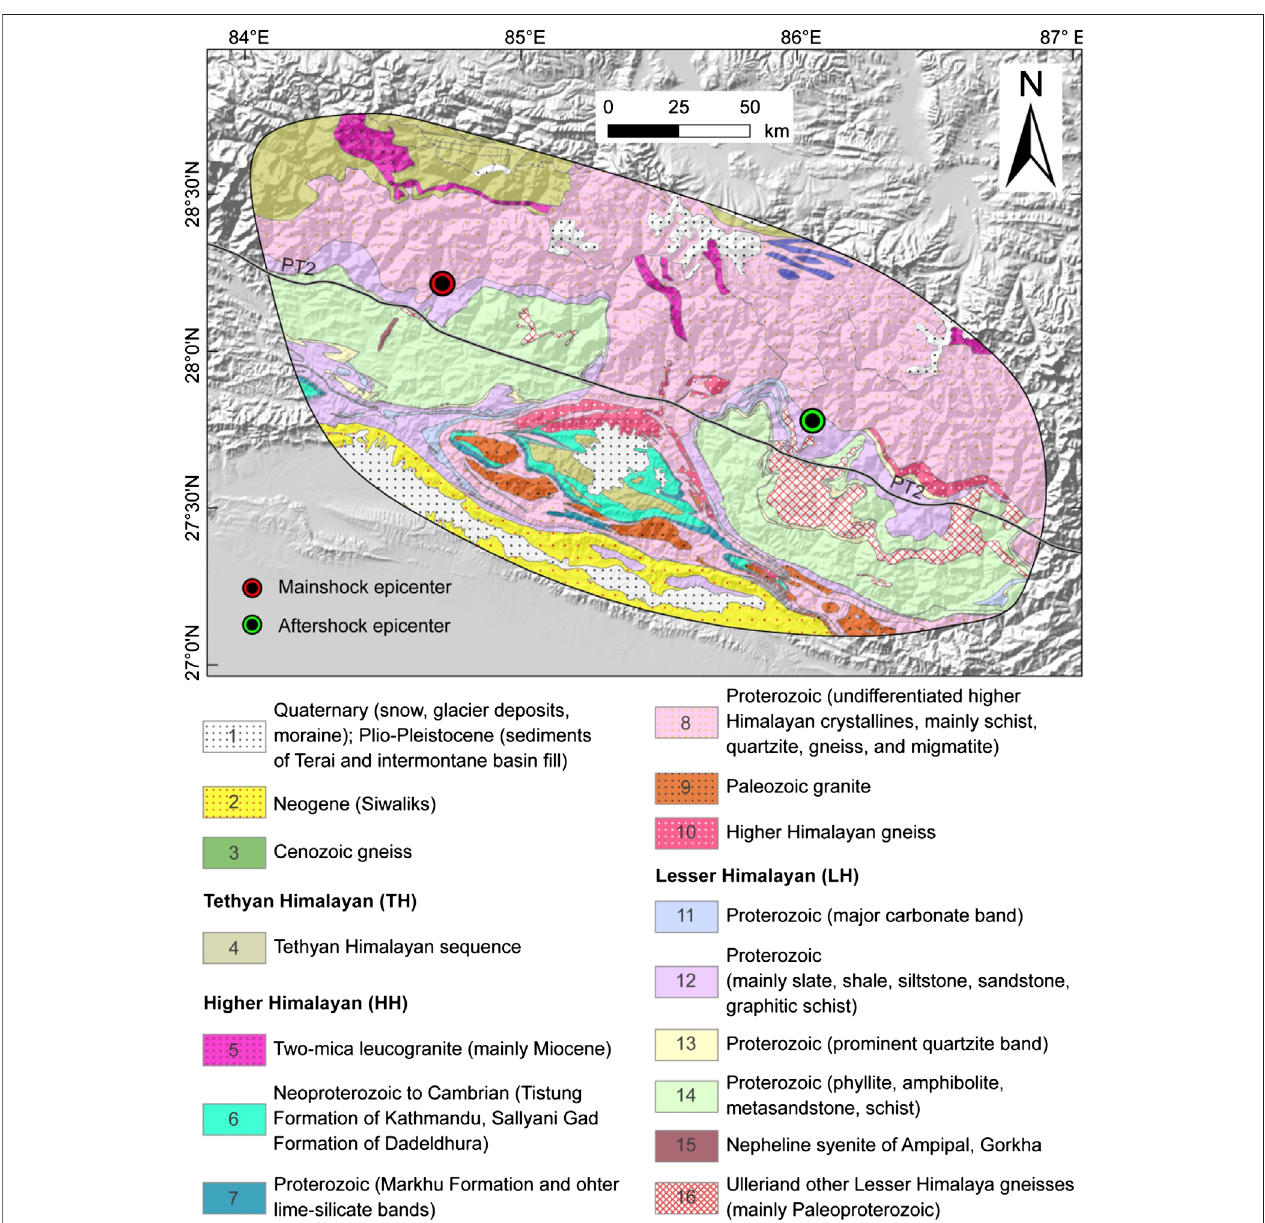
FIGURE 5 | Geology of the study area. The part in Nepal is from Dhital (2015), Kargel et al. (2016), and Tiwari et al. (2017); the area in China is from National Geological Data Museum of China (2013).